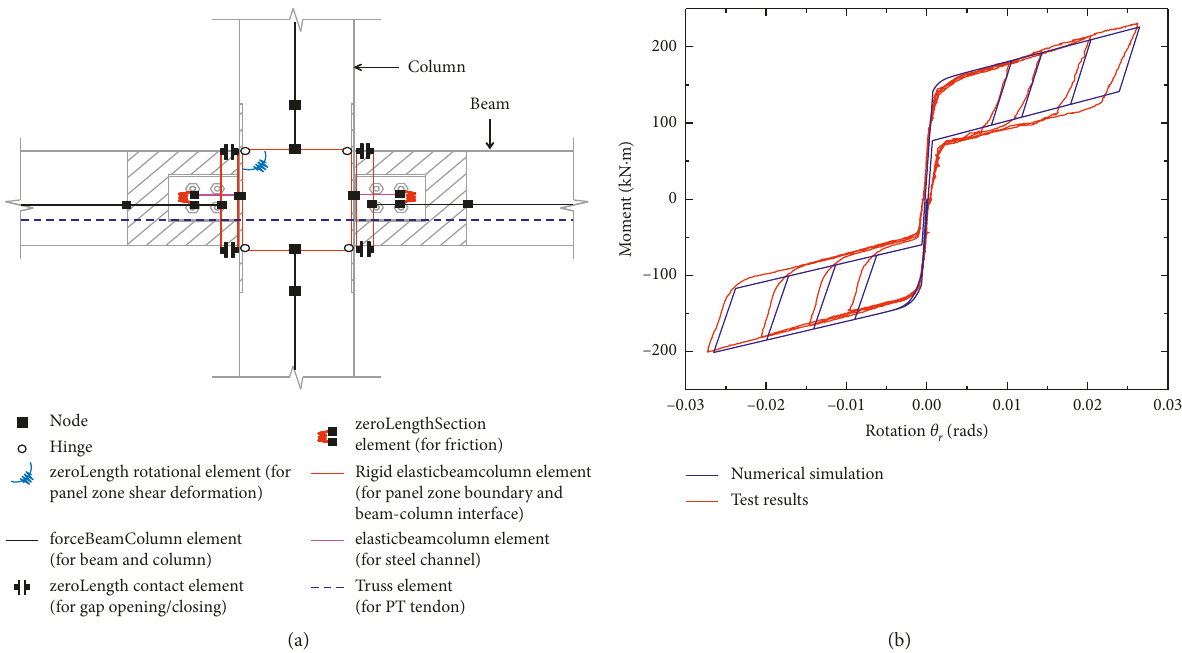
Figure 3: Numerical model for the SC beam-column connection and experimental validation. (a) OpenSees model of SC beam-column connection. (b) Comparison of numerical and experimental results [16].